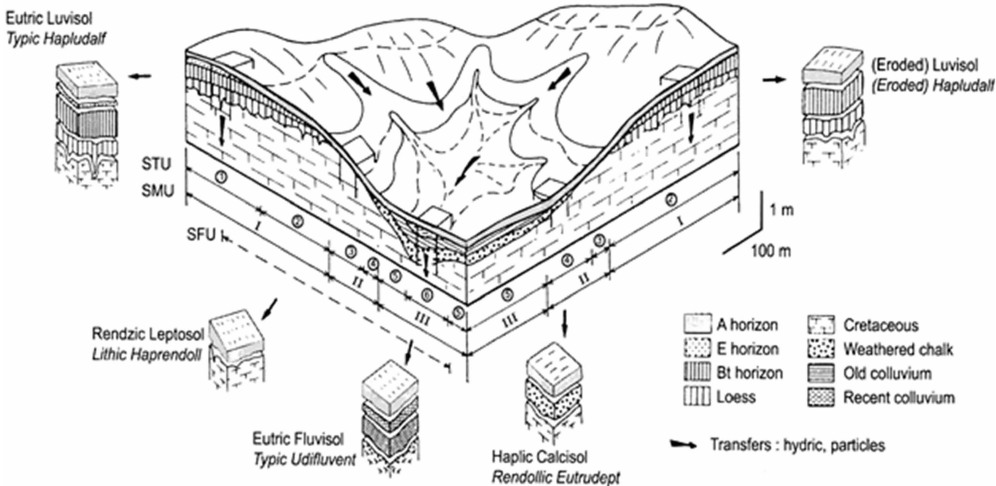
Fig. 2. Block diagram from the basin of Paris, illustrating the occurrence of different types of soil at different positions in the landscape. This diagram includes limestone bedrock, deep soils on the plateaus, thin ones on the slope and deep ones in the valleys. Streamlines of surface flow of water are determined by infiltration rates at the surface and by